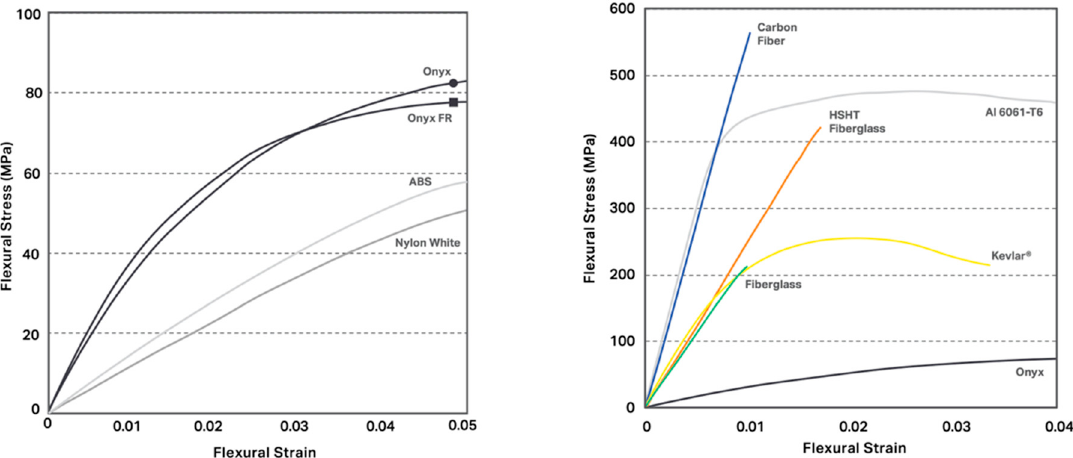
Figure 2. Bending stress as a function of deformation. On the left, material not continuously reinforced; on the right, with the continuous reinforcement [16].